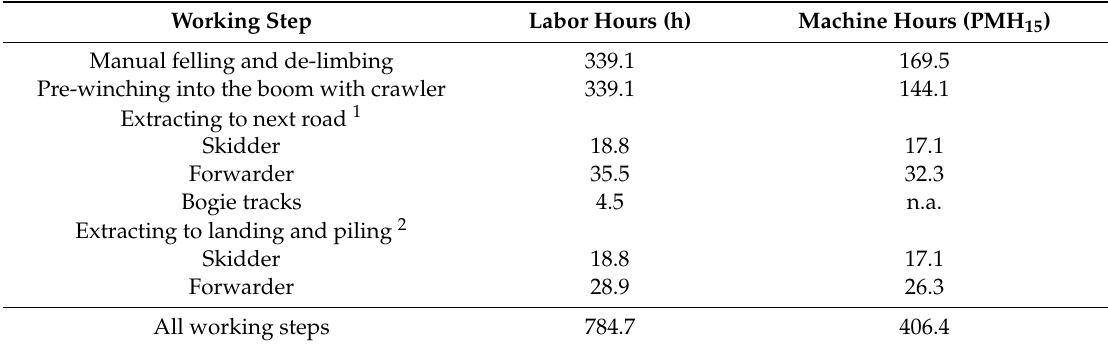
Table 7. Required labor and machines for the di ff erent working steps in the ground-based FO.